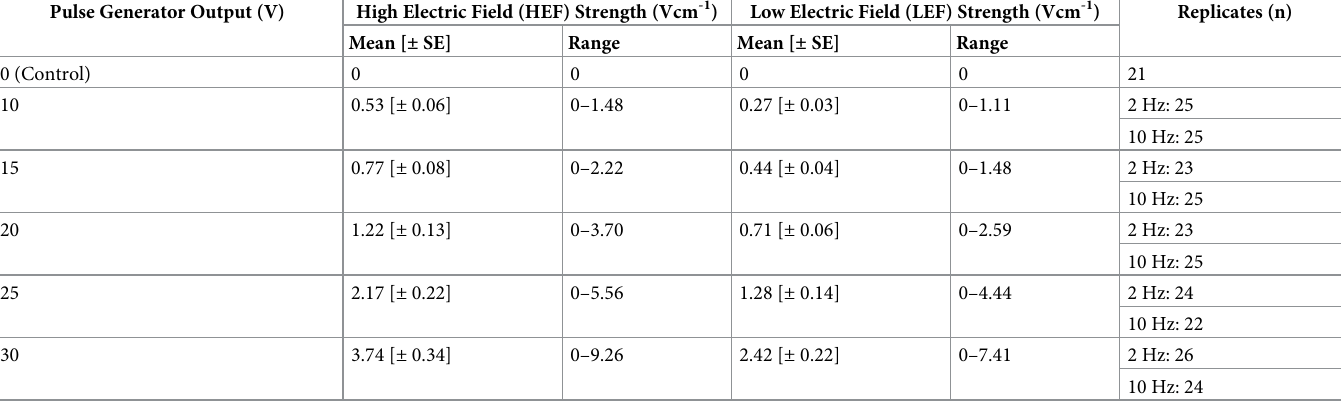
Table 1. The characteristics of the electric fields generated in adjacent High (HEF) and Low Electric Field (LEF) strength routes in an experimental flume under 10 treatments and a control. Pulse Generator Output (V)